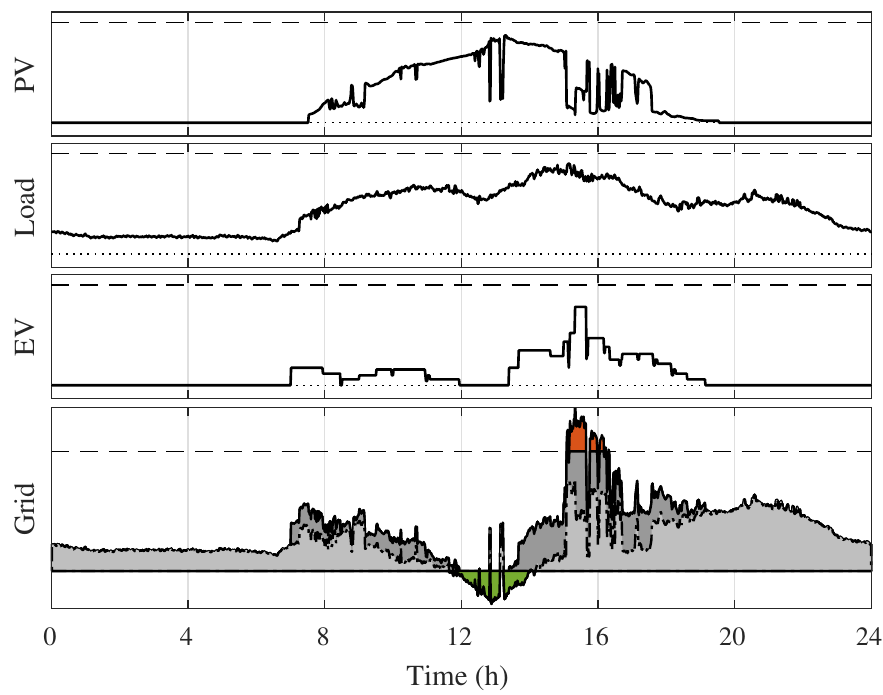
Figure 1. Impact of electric vehicles’ charging on the demand of a